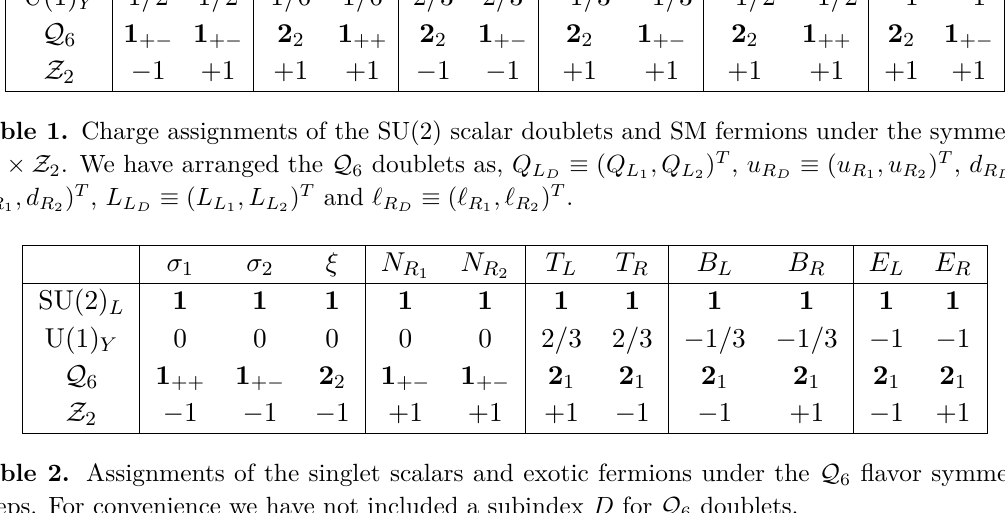
6 flavor symmetry